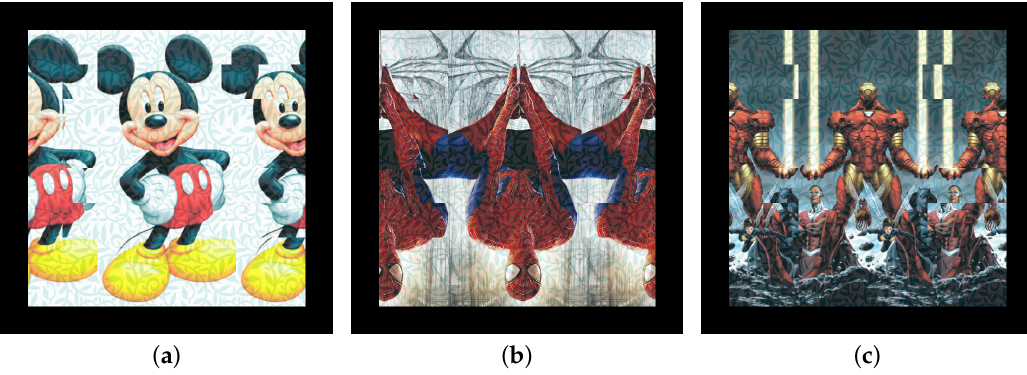
Figure 9. Three examples of PMBC tags that conceal the same multi-level bar-code. ( a ) Mickey tag; ( b ) Spider-Man tag; ( c ) Iron Man